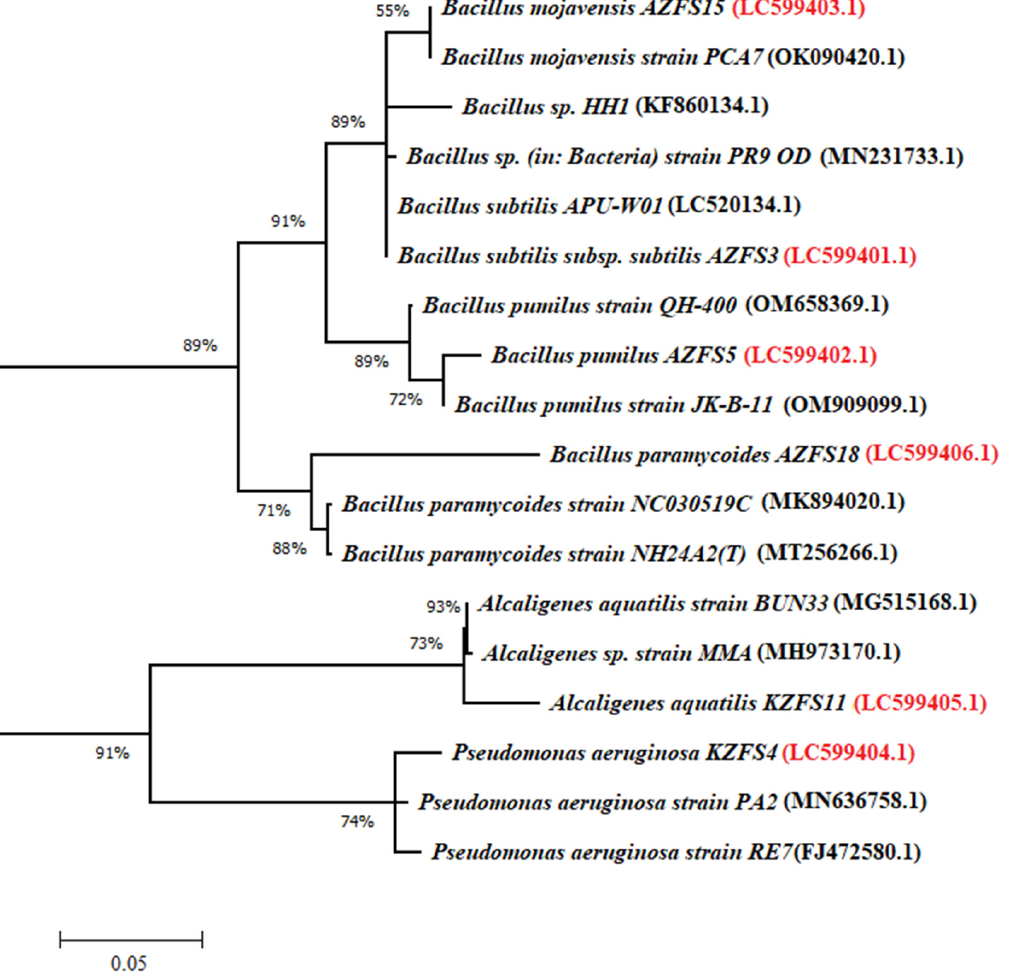
Figure 1. Neighbor-joining tree showing the phylogenetic relationships between four Bacillus strains, pseudomonas, and Alcaligenes , and the type strains based on 16S rRNA gene sequences. The numbers at the branch nodes are bootstrap percentages (100 replicates), and the bar indicates a 0.5% sequence. The sequence similarities of AZFS5 (LC599402.1), AZFS15 (LC599403.1), AZFS18 (LC599406.1), KZFS4 (LC599404.1), and KZFS11 (LC599405.1) were 97, 99, 91, 98, and